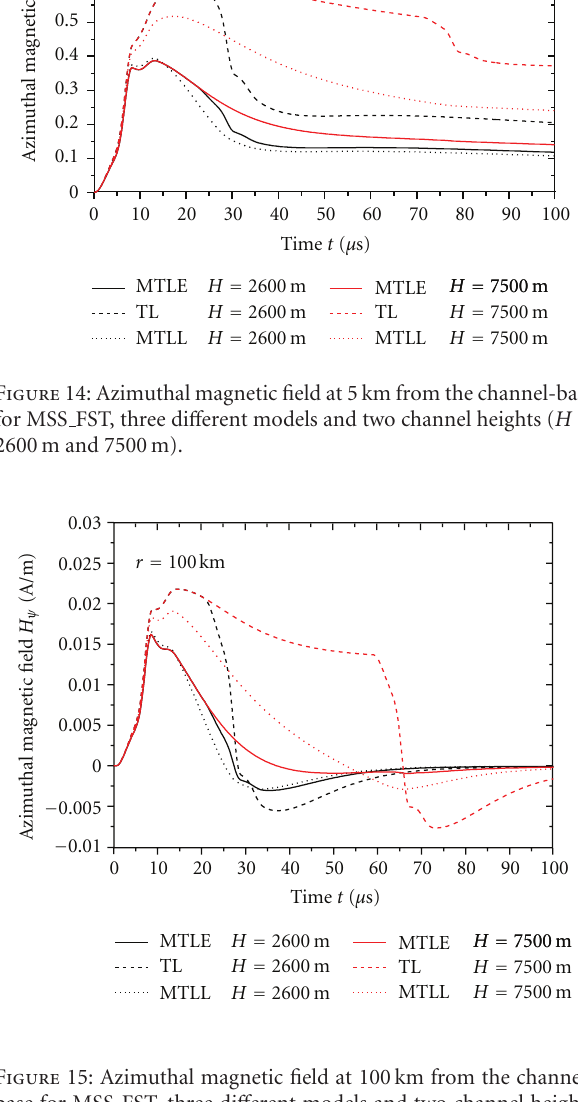
Figure 13: Azimuthal magnetic field at 50m from the channel base for MSS FST, three di ff erent models and two channel heights ( H = 2600 m and 7500 m).